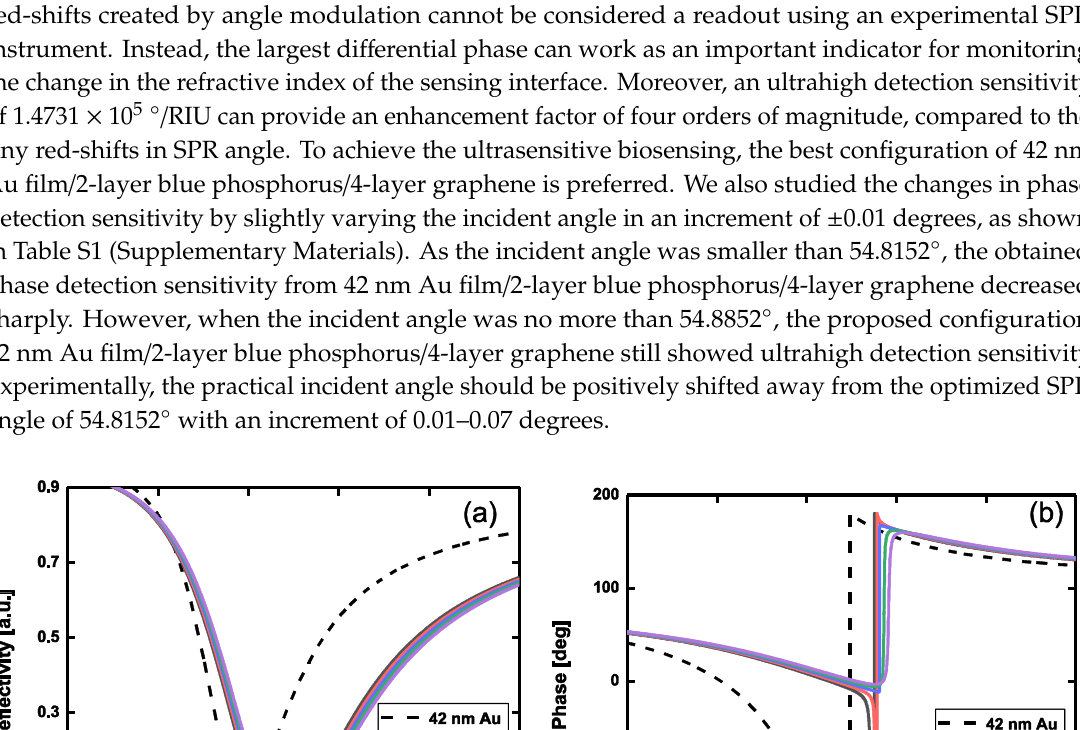
Table 1. The optimized values of Au film thickness, the number of BlueP layers, the changes in SPR incident angle ( △ θ SPR ), the changes in differential phase ( d  ), minimum reflectivity, and sensitivity.